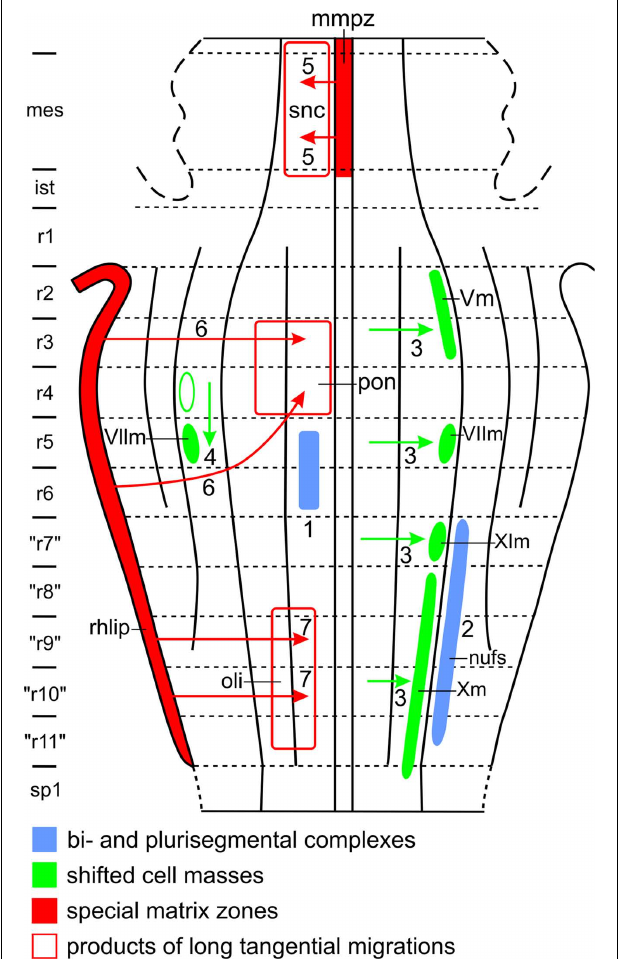
FIGURE 11 | Features which may complicate the morphological interpretation of topological charts. For explanation, see